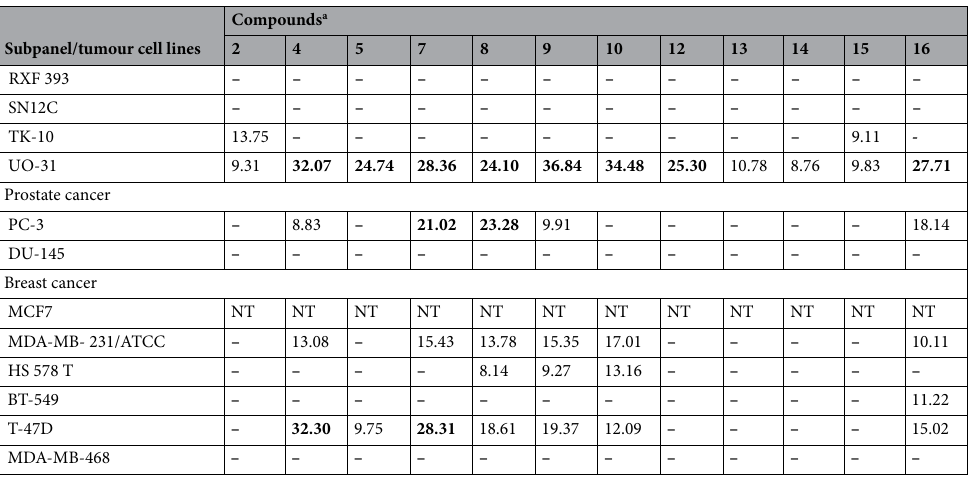
Table 1. In vitro anticancer screening results of compounds 2, 4, 5, (7–10) and (12–16) against sixty human tumour cell lines with single dose assay (10 –5 M concentration). Data was provided as cell growth inhibition percentage. a Only GI % higher than 8% are shown. NT not tested. Significant values are in